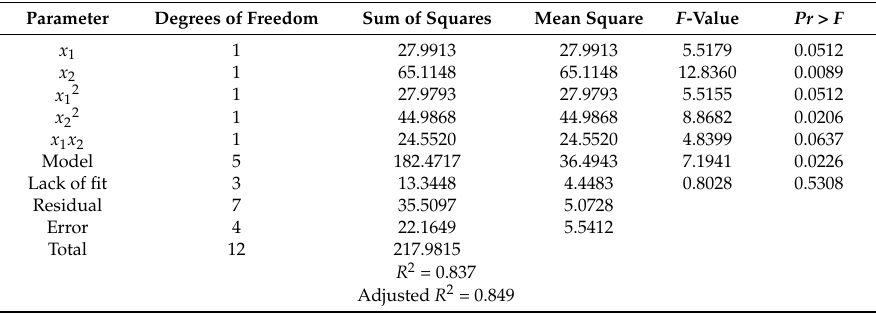
Table 5. Regression coefficient, standard error, and ANOVA (Analysis of Variance) for the regression model of net ecosystem productivity (NEP).